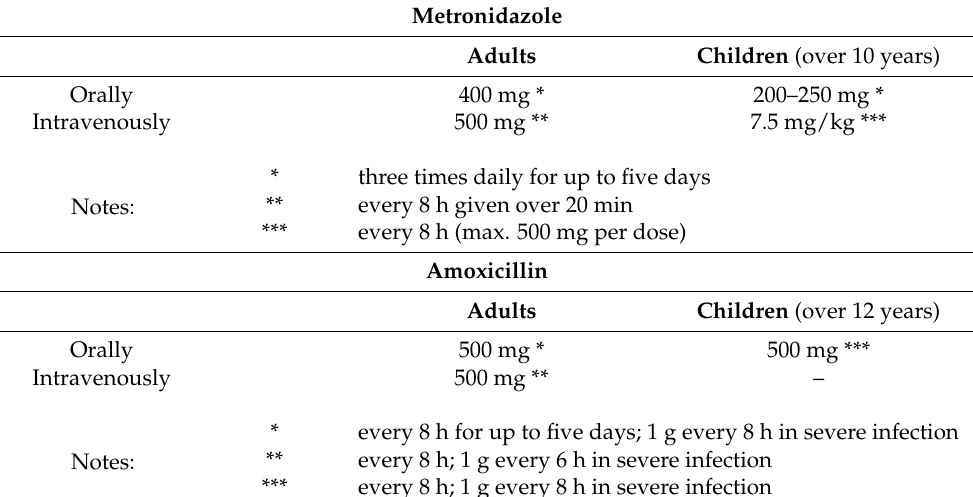
Table 3. Antibiotic prescription for pericoronitis. Symbols (*) indicate further notes. Notes are provided within the table.